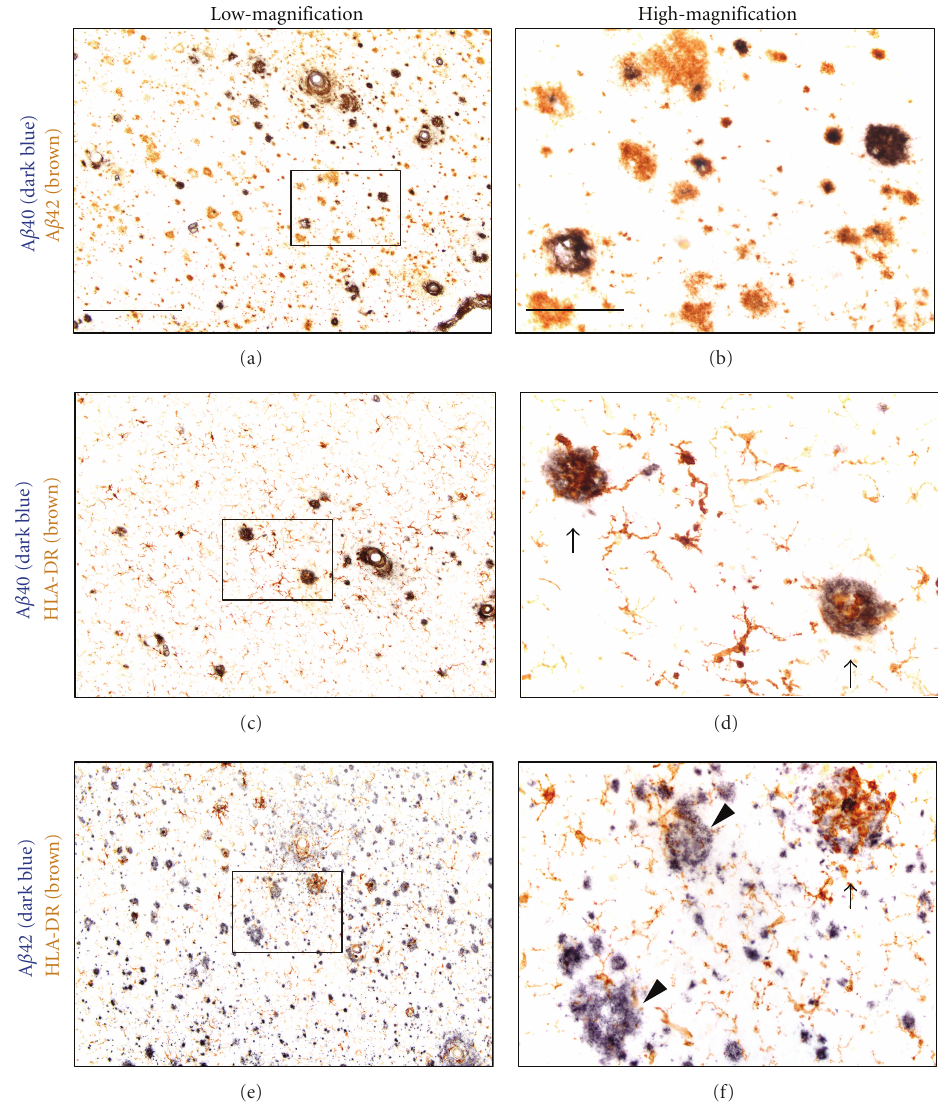
Figure 5: Immunohistochemical study of microglial accumulation on A β plaques in human AD brains. Free-floating human AD brain sections were incubated with the anti-A β 40 specific antibody (dark blue) and anti-A β 42 specific antibody (brown) (a, b), anti-A β 40 specific antibody (dark blue) and anti-HLA-DR antibody (for microglial staining; brown) (c, d), and anti-A β 42 specific antibody (dark blue) and anti-HLA-DR antibody (for microglial staining; brown). Arrows and arrow heads show marked and poor microglial accumulations, respectively. (b), (d), and (f) show high-magnification views of squared area in (a), (c), and (e), respectively. Scale bar in (a) equals 400 μ m for (a), (c), and (e). Scale bar in (b) equals 100 μ m for (b), (d), and